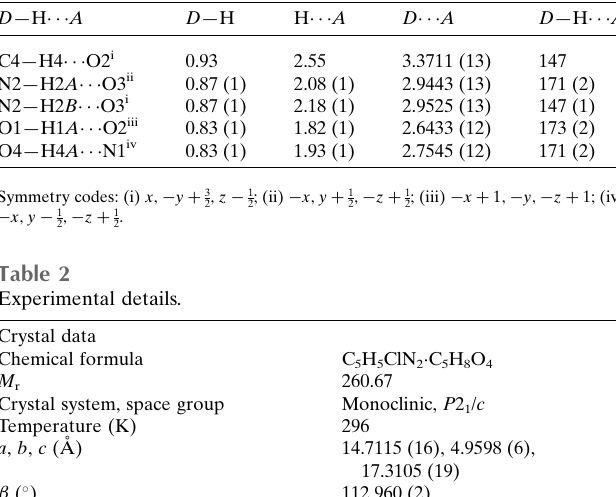
Figure 1 The asymmetric unit of the title compound. Displacement ellipsoids for non-H atoms are drawn at the 50% probability